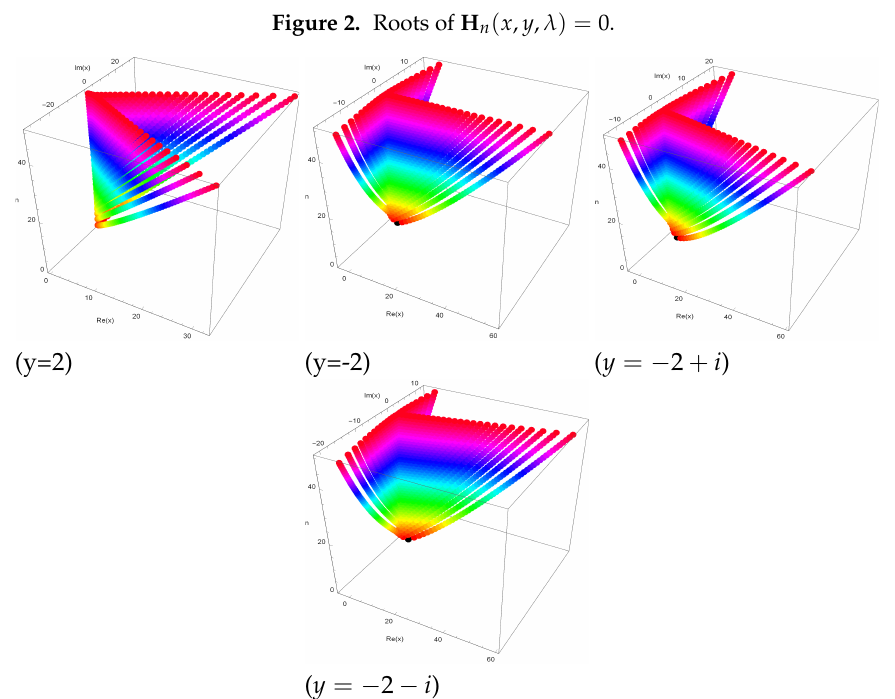
Figure 2. Roots of H n ( x , y , λ ) = 0.